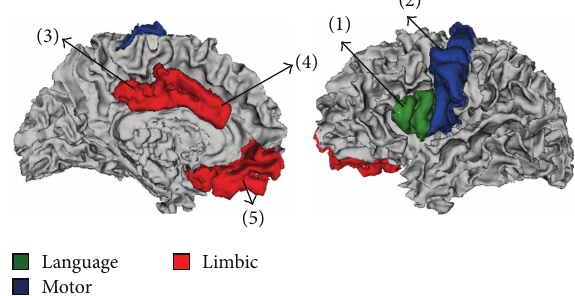
Figure 3: Anatomical locations of cortical brain areas in which significantgroupdifferencesweredetectedforthecorticalthickness, surface area, and CBF parameters; language area (green); motor area (blue); and limbic area (red). (1) Pars opercularis; (2) precentral; (3) posterior cingulated; (4) caudal anterior cingulate; and (5) medial